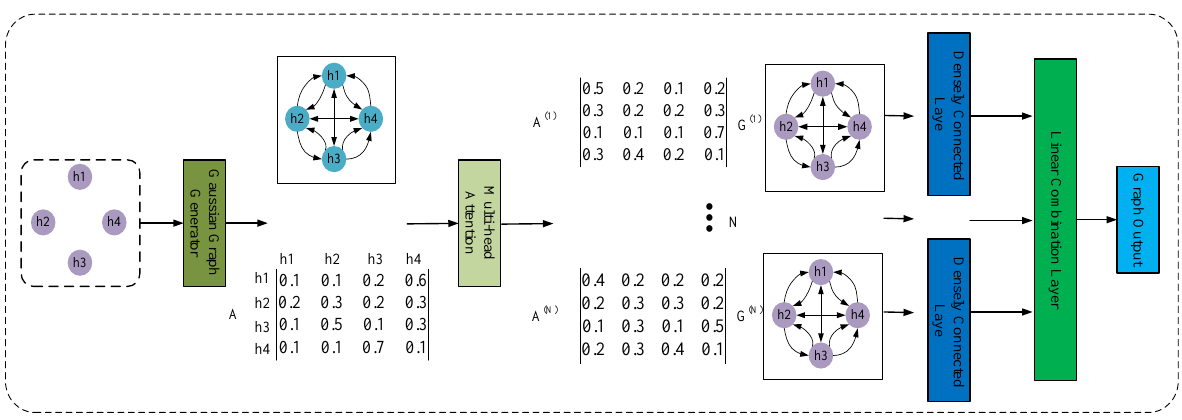
Figure 2. The model of SGNet. It includes the BERT model, graph model, and joint decoding model, where sh stands for subject head, st for subject tail, oh for object head, and ot for object tail.